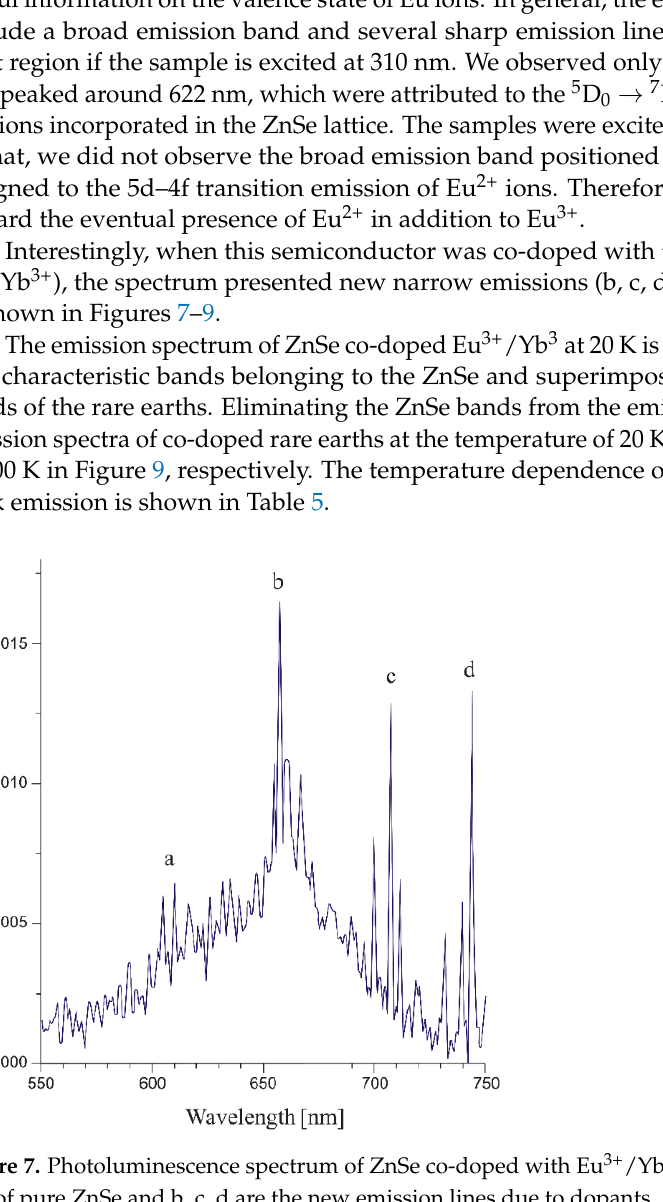
Figure 8. Photoluminescence spectrum of ZnSe co-doped with Eu 3+ /Yb 3+ at 20 K without the ZnSe con- tribution. a is the emission line of pure ZnSe and b, c, d are the new emission lines due to dopants. Figure 9. Photoluminescence spectrum of ZnSe co-doped with Eu 3+ /Yb 3+ at 200 K after eliminating the ZnSe bands. a is the emission line of pure ZnSe and b, C are the new emission lines due to dopants.